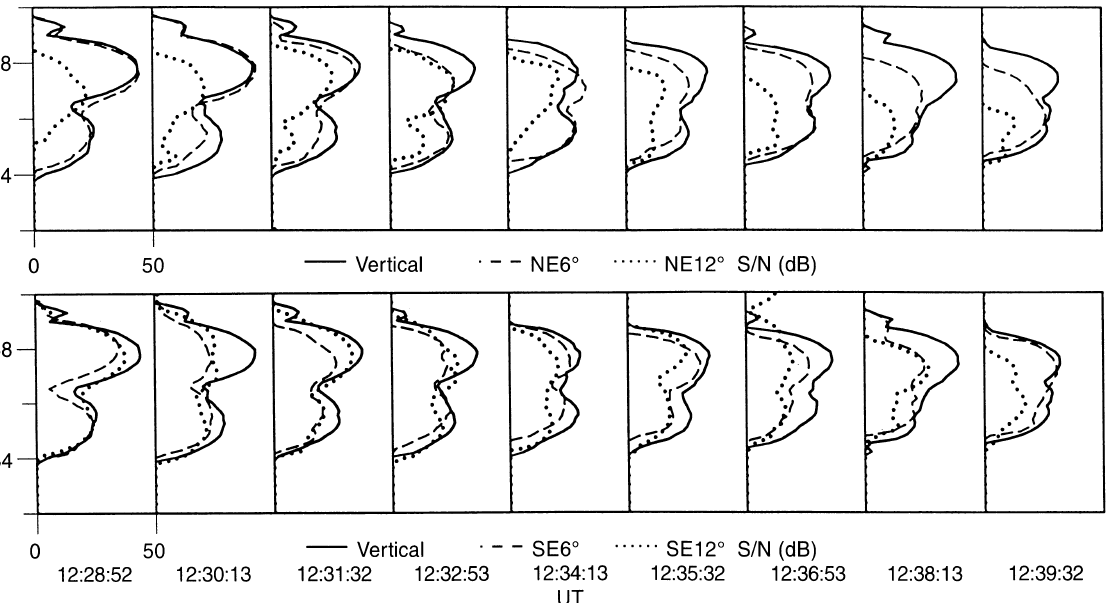
Fig. 8a, b. Altitude profiles of the S/N for the vertical and 6 (cid:14) and 12 (cid:14) beams in a the NE azimuth and b SE azimuth for nine consecutive cycles of observation on 8 July